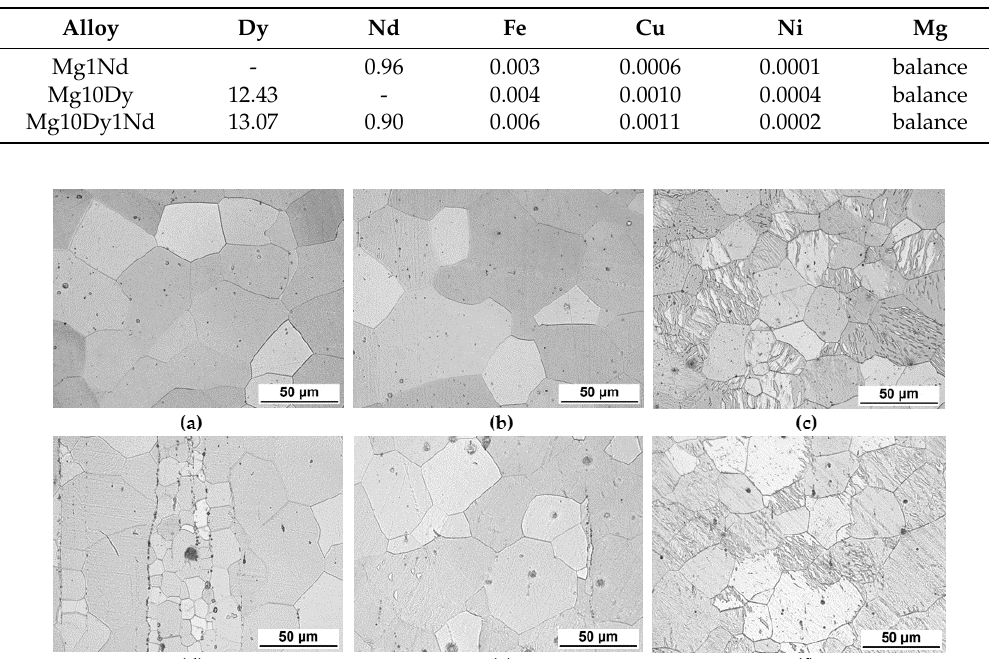
Table 1. Chemical composition and impurity level of the extruded alloys in wt%.